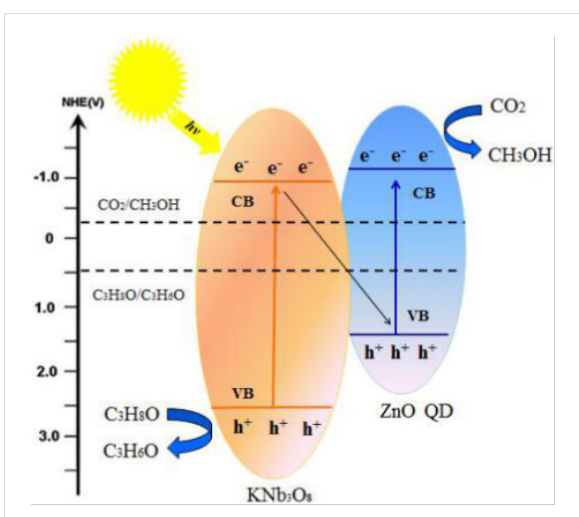
Figure 11: Mechanism of the photocatalytic reduction of CO 2 to meth- anol on the ZnO quantum dot/KNb 3 O 8 nanosheet composite photocat-